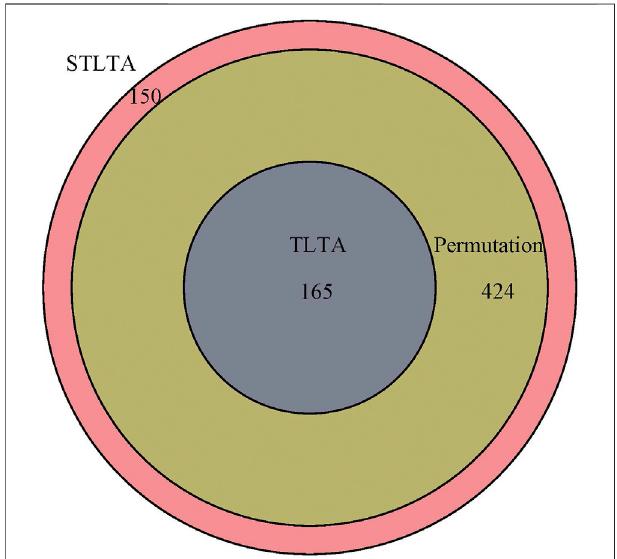
FIGURE 2 | The Venn diagram of the signi fi cant relationships found in permutation test, TLTA and STLTA for the MPHM “ M3 ” fecal data set. Green, blue, and red indicate the number of signi fi cant relationships found by permutation test, TLTA, and STLTA,